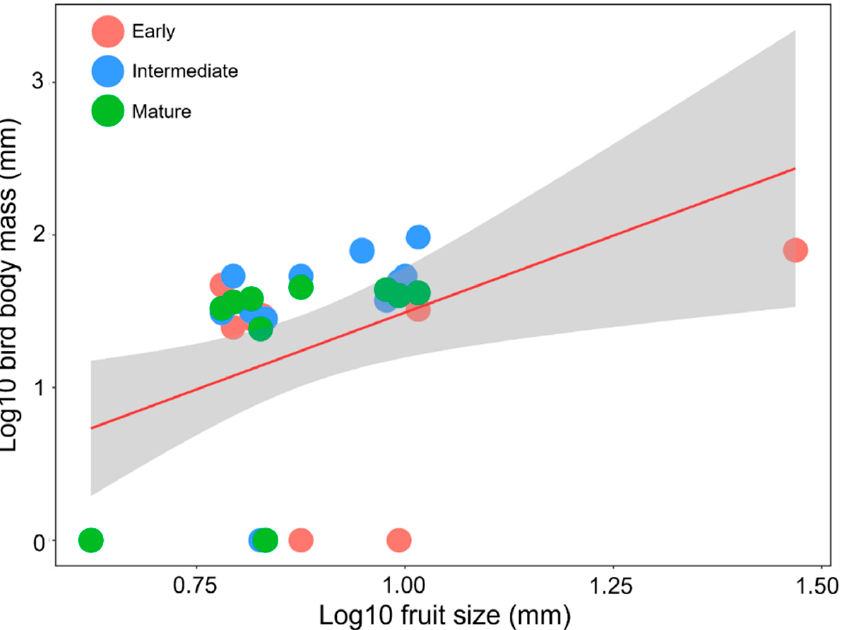
Figure 4. Relationship between bird body mass and fruit size of zoochorous trees along the succes- sional TDF gradient in southern Mexico. The solid line represents a linear regression, and grey colour shows the 95% confidence interval.